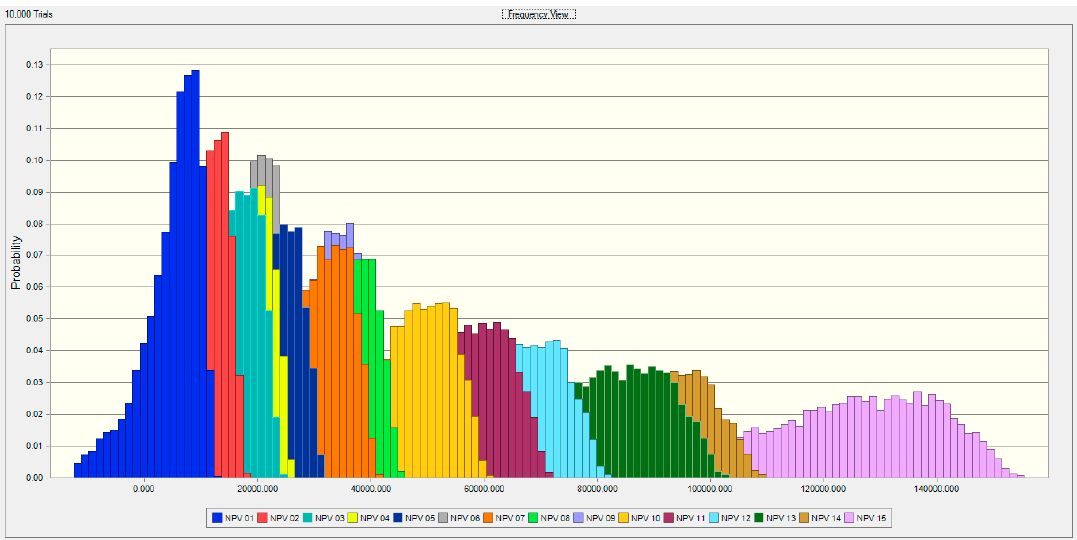
Figure 2. Overlay charts of NPV distributions.